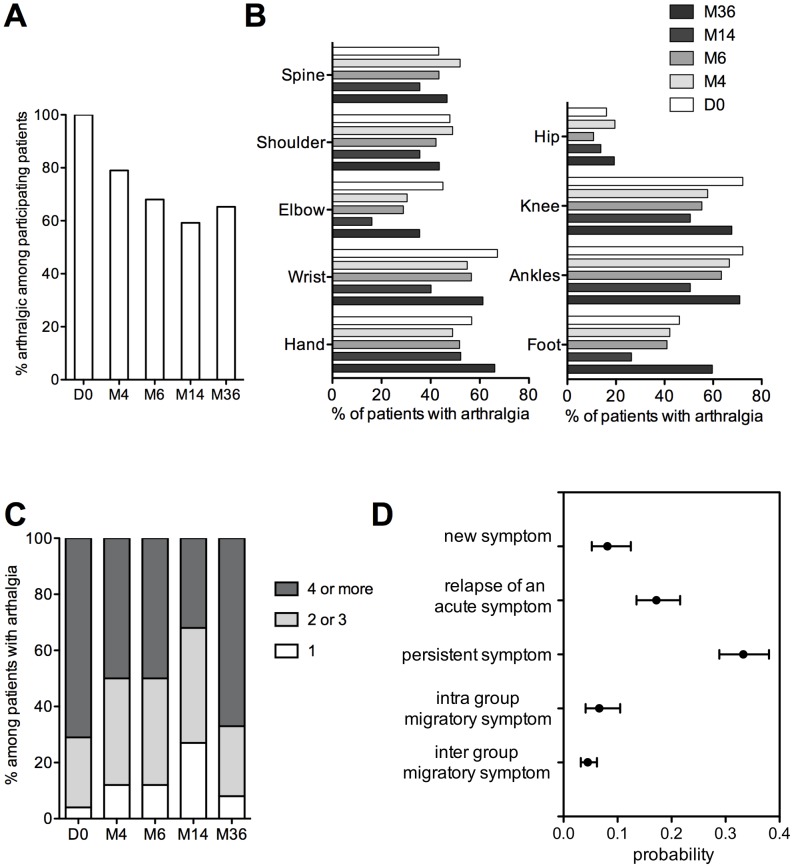
Evolution and characterization of arthralgia in CHIKV patients.(A) Percentage of patients with arthralgia among participating patients, (B) localization of arthralgia among patients with arthralgia, (C) number of arthralgia sites among the 76 patients answering at every time point and having arthralgia, (D) complete model presenting the probability for one joint to be painful depending on its previous state.